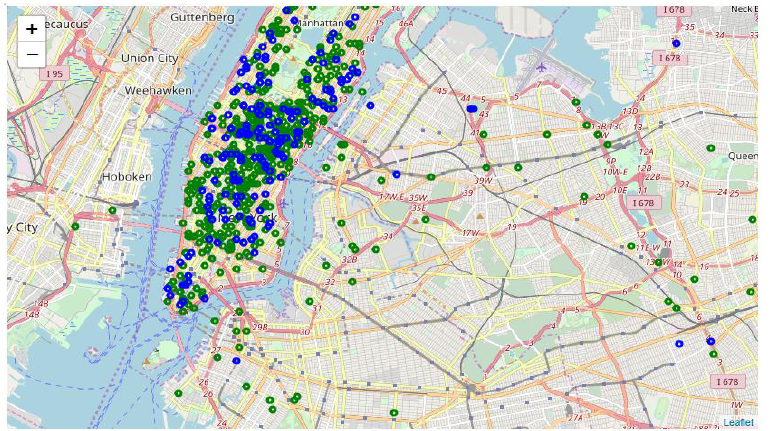
Figure 6. Blue and green bubbles illustrate the pick-up and drop-off